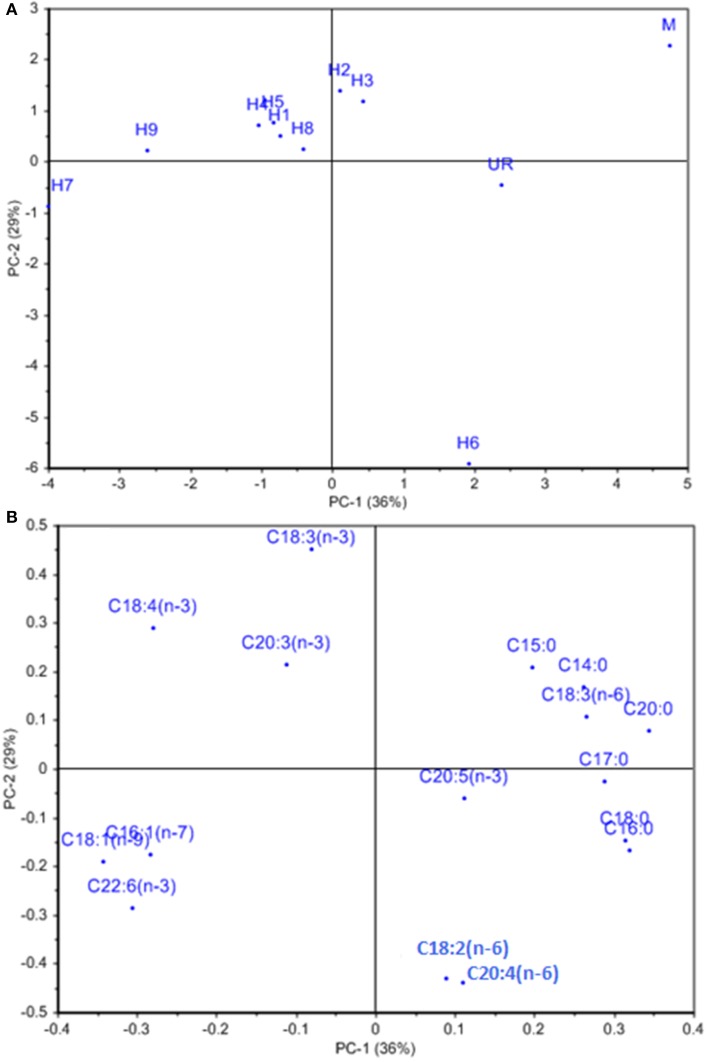
(A) Loading and (B) score plot of hybrids and the fusion partners obtained from PCA analysis of fatty acid data matrix. % represents the explained variance at PC1 and PC2.